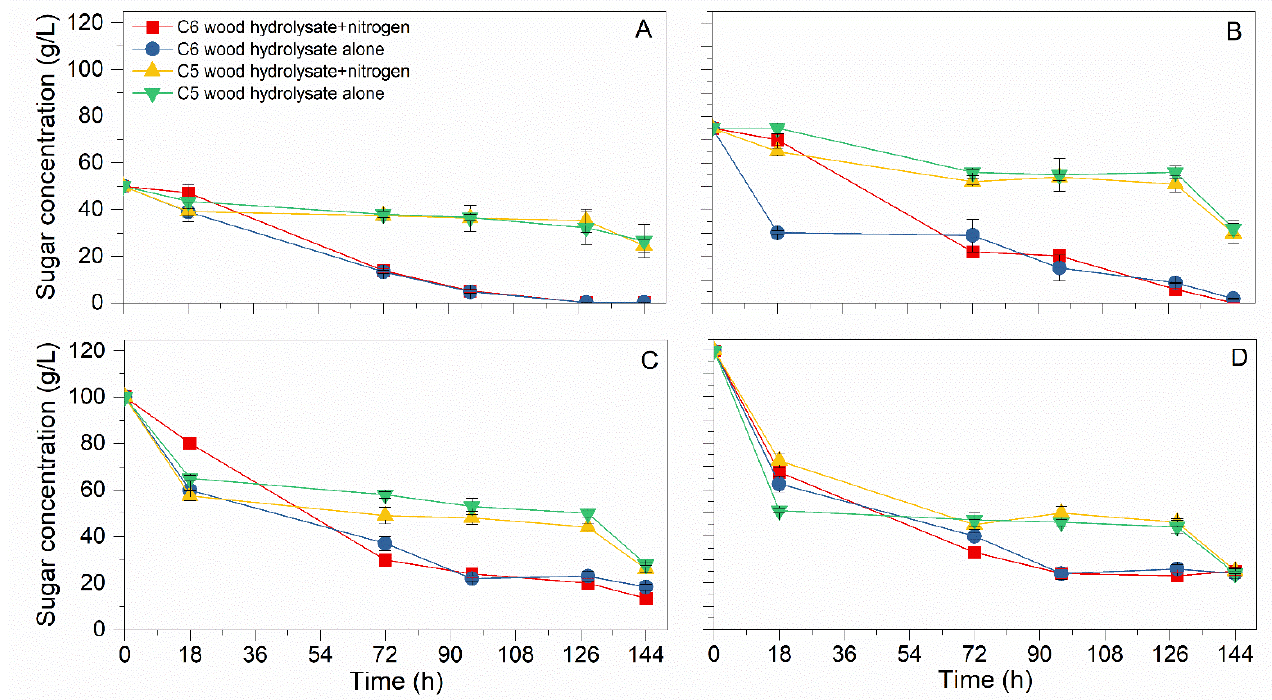
Figure 1. Sugar consumption profile by R. toruloides -1588 using wood hydrolysate as a culture media. A) 50 g/L; B) 75 g/L; C) 100 g/L; D) 120 g/L.